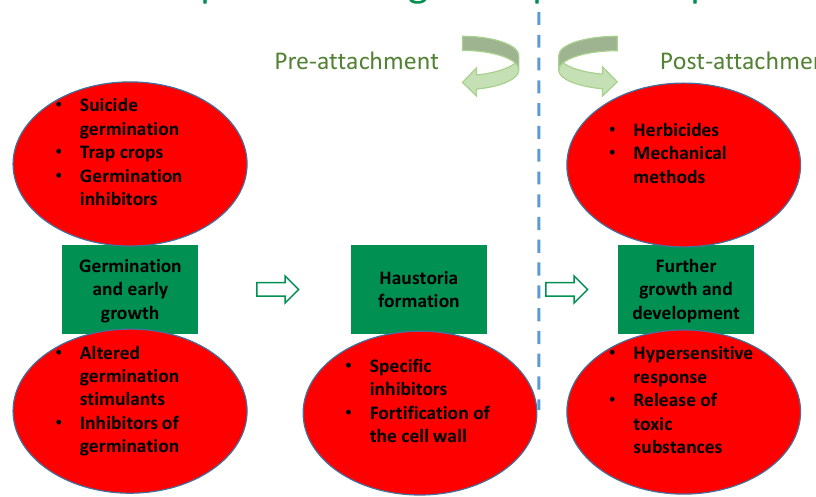
Figure 1. Summary of the most widely applied methods of control and host resistance mechanisms to parasitic plants as dependent on the developmental stages.